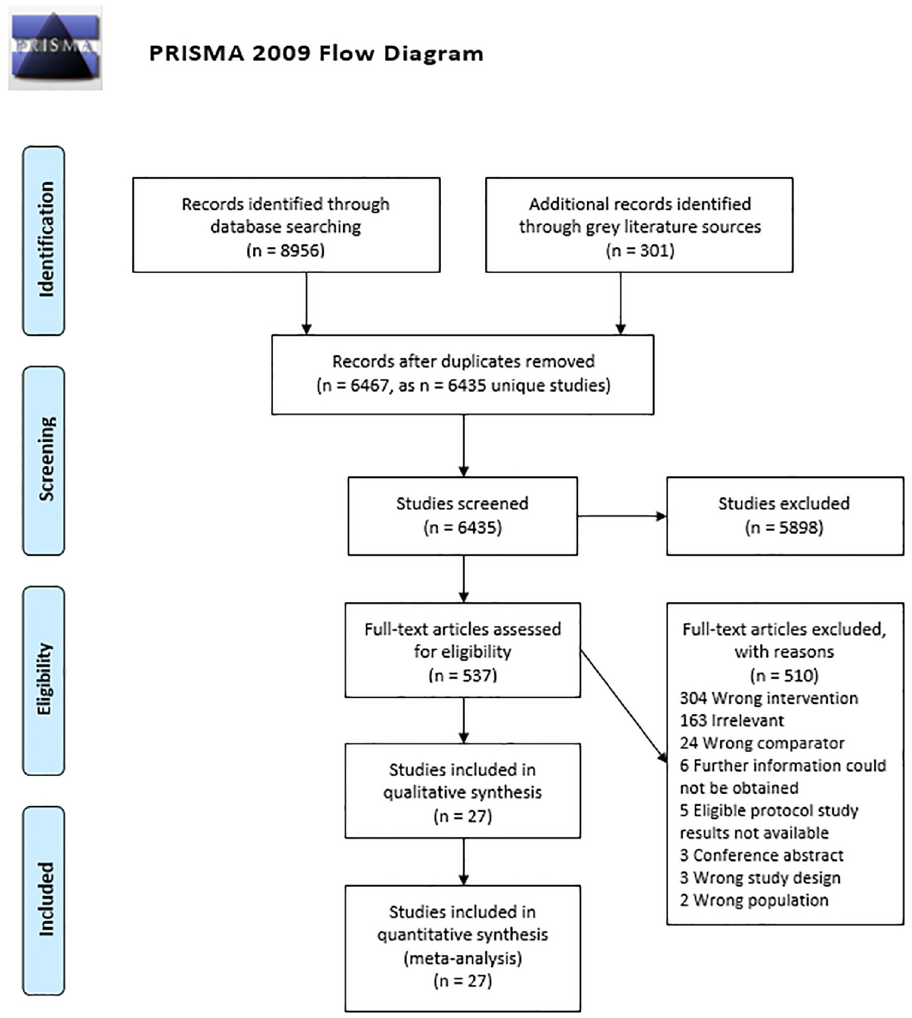
Fig 1. PRISMA flow diagram of the systematic literature